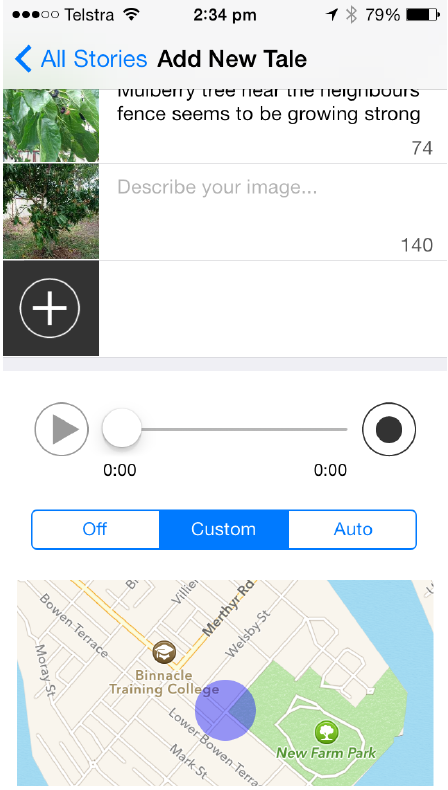
Figure 4. QuickTales application screenshots: Creating